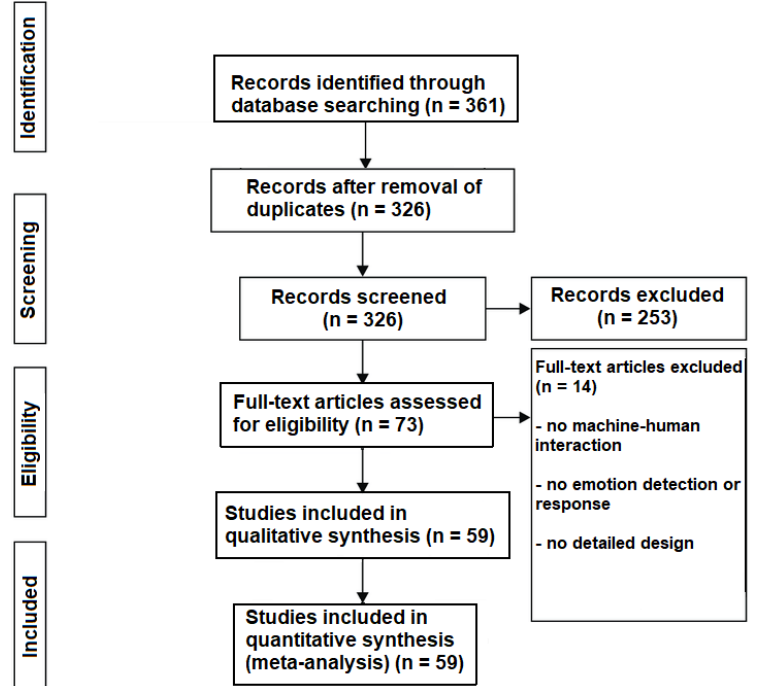
Figure 2. PRISMA flow